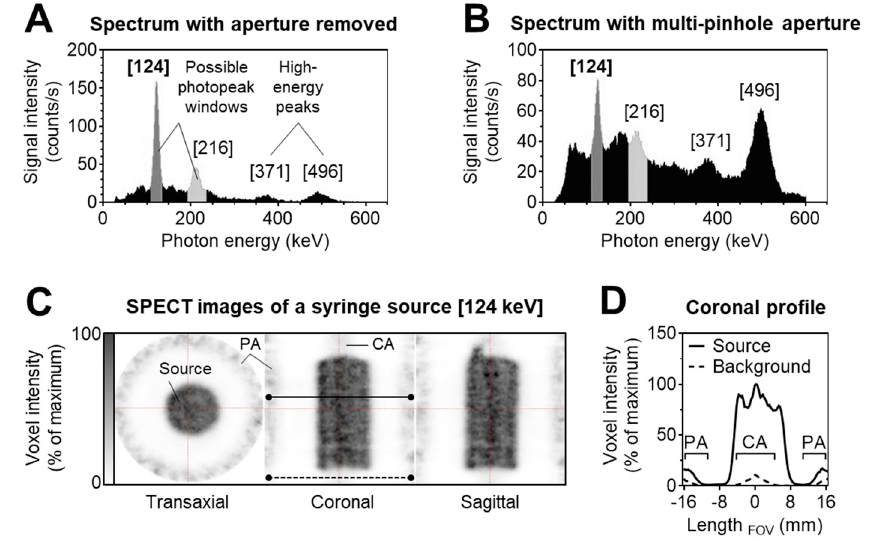
Figure 7. Single photon emission computed tomography (SPECT) imaging performance of barium-131. ( A ) Energy spectrum of a 0.5 MBq point source recorded without aperture showing two possible photopeaks at 124 keV and 216 keV (grey) and two high-energy peaks at 371 keV and 496 keV (black); ( B ) energy spectrum of a 3 MBq syringe source recorded with multi-pinhole aperture showing relative increase of high-energy peaks and noise (black) contaminating the desired photopeak windows (grey); ( C ) orthogonal SPECT images of a 3 MBq syringe source recorded using the 124 keV photopeak window; positions of representative axes for measurement of voxel intensity profiles; dashed line: Background zone, n = 6; continuous line: Source zone, n = 9; ( D ) voxel intensity profiles of the central of the coronal image slice shown under C; peripheral artifacts (PA) occurring in the periphery of the field of view (FOV); central artifacts (CA) occurring along the central anterior-posterior axis of the FOV.